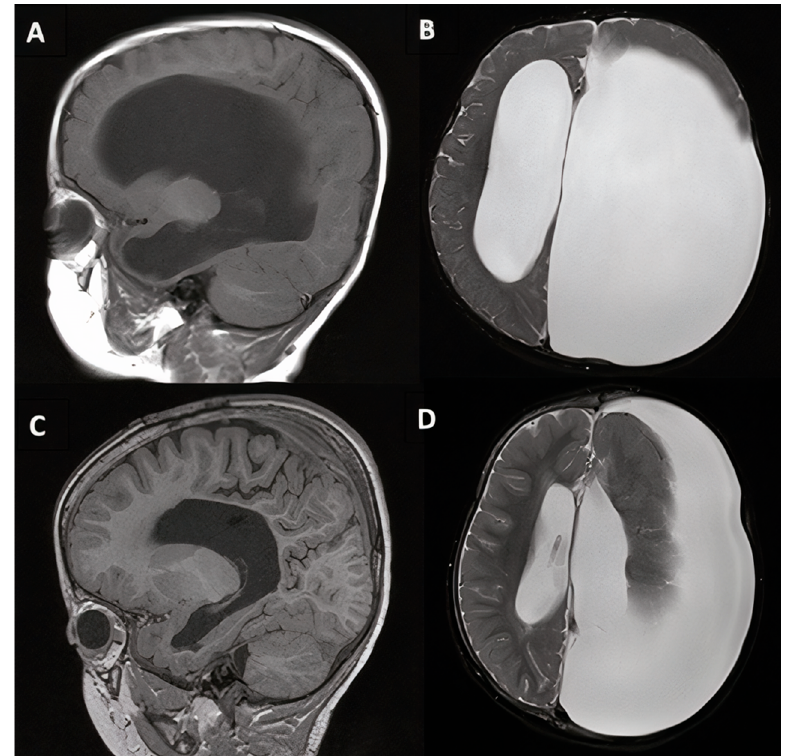
Figure 6. 18-month-old male patient with left-sided porencephalic cyst secondary to intrauterine cerebral ischemia (case #9). Pre-operative ( A , B ) and 2 years post-operative ( C , D ) T1-weighted right-sided sagittal and T2-weighted axial magnetic resonance imaging (MRI), demonstrating ventriculomegaly as well as left-sided porencephalic cyst.